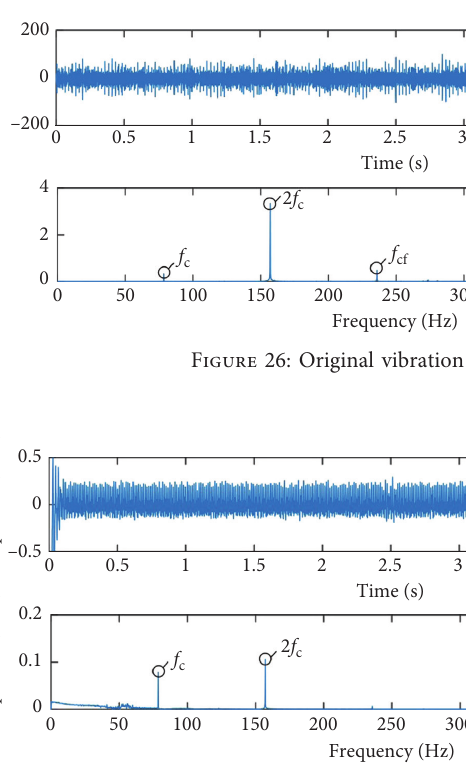
Figure 27: Signal processed by USSR.